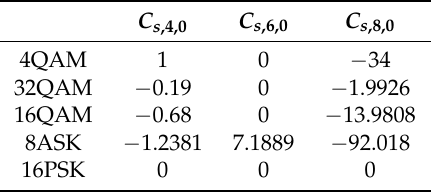
Table 1. Cumulant values of candidate